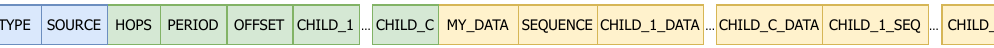
Figure 4. Format of the UP_DATA frame from sensor.